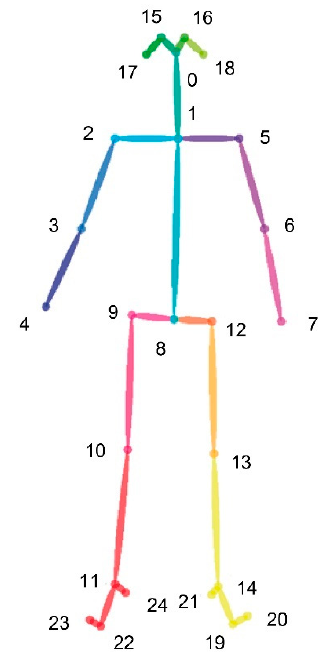
Figure 3. Joint virtual disposition .